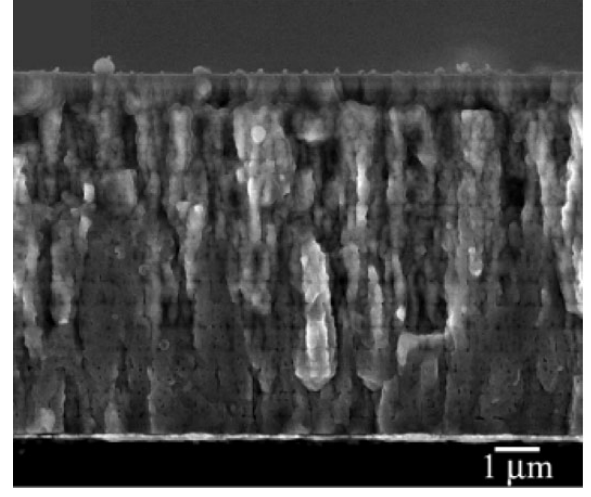
Figure 6. Cross-sectional image of 8 μ m-thick (100) oriented PZT film using sol-gel [41].